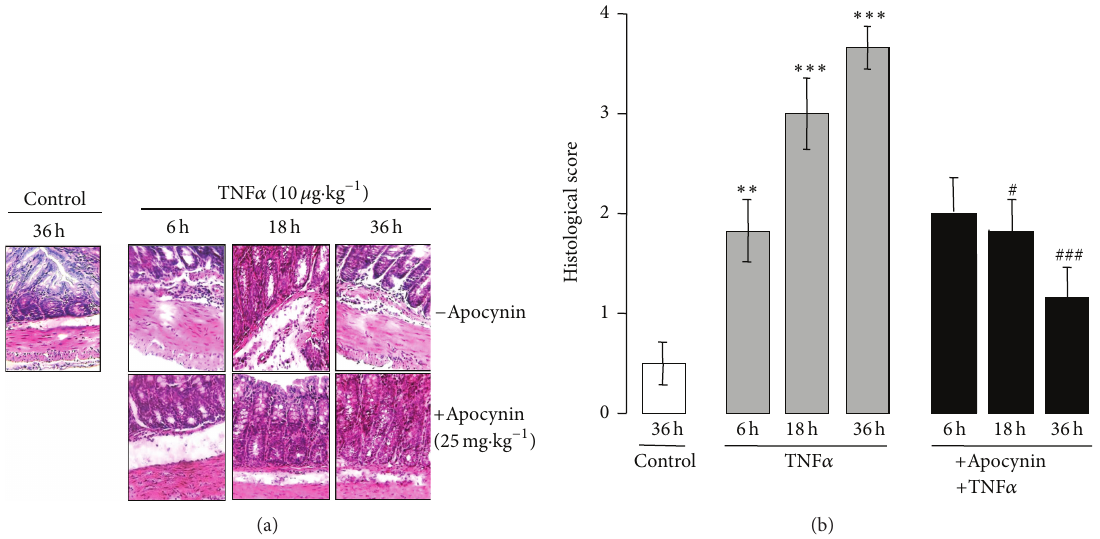
Figure 2: Apocynin improves TNF 𝛼 -induced histological changes of the colon. (a) Histological examination of the colon sections of mice treated with TNF 𝛼 (10 𝜇 g ⋅ kg −1 , ip) in the presence or absence of apocynin (25mg ⋅ kg −1 , ip). Mice were treated as described in Figure 1(a), and colon sections were stained with hematoxylin and eosin (H&E) and analyzed by light microscopy (Gx400); (b) histological score damage in the colon of mice treated with TNF 𝛼 (10 𝜇 g ⋅ kg −1 , ip) in the presence or absence of apocynin (25 mg ⋅ kg −1 , ip). Results from mice treated with 10 𝜇 g kg −1 TNF 𝛼 were matched to control mice with Mann-Whitney’s 𝑈 test. Values are means ± SEM from 𝑛 = 5 mice in each group. ∗∗ 𝑃 < 0.01 and ∗∗∗ 𝑃 < 0.001 versus control group; # 𝑃 < 0.05 and ### 𝑃 < 0.001 versus TNF 𝛼 -treated